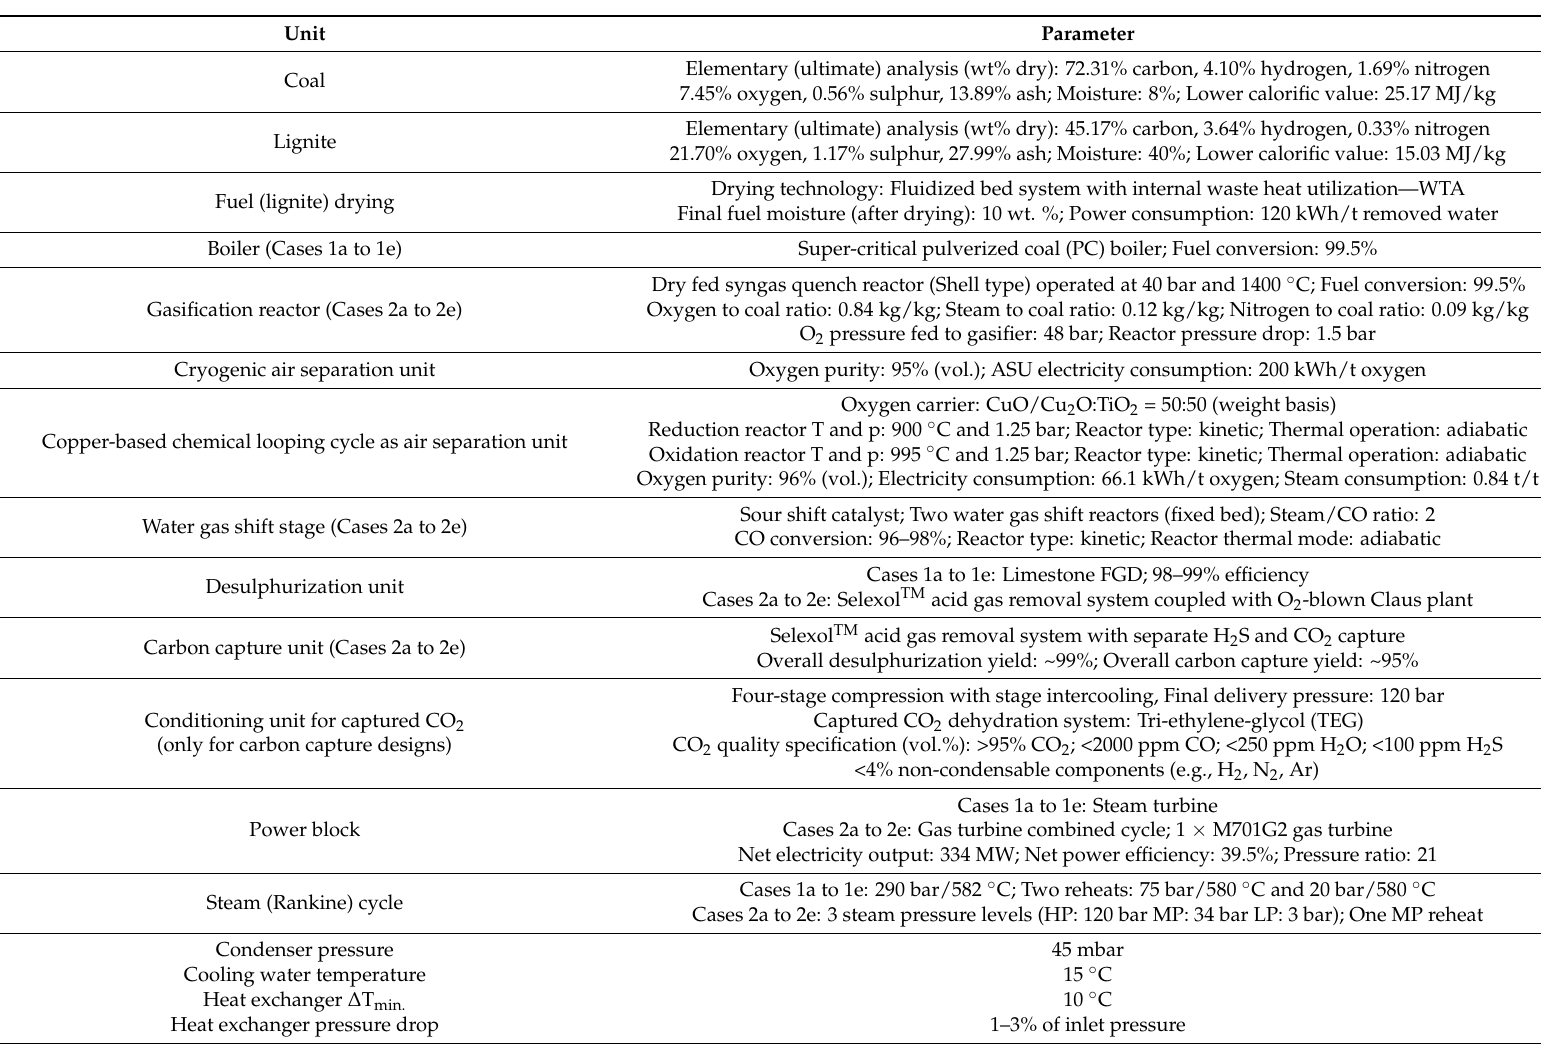
Table 1. Main model assumptions of evaluated oxy-combustion and gasification power plants integrated with copper-based CLAS